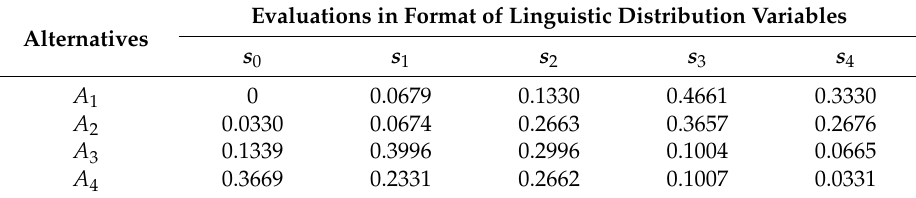
Table 5. The linguistic distribution evaluations on criterion C 5